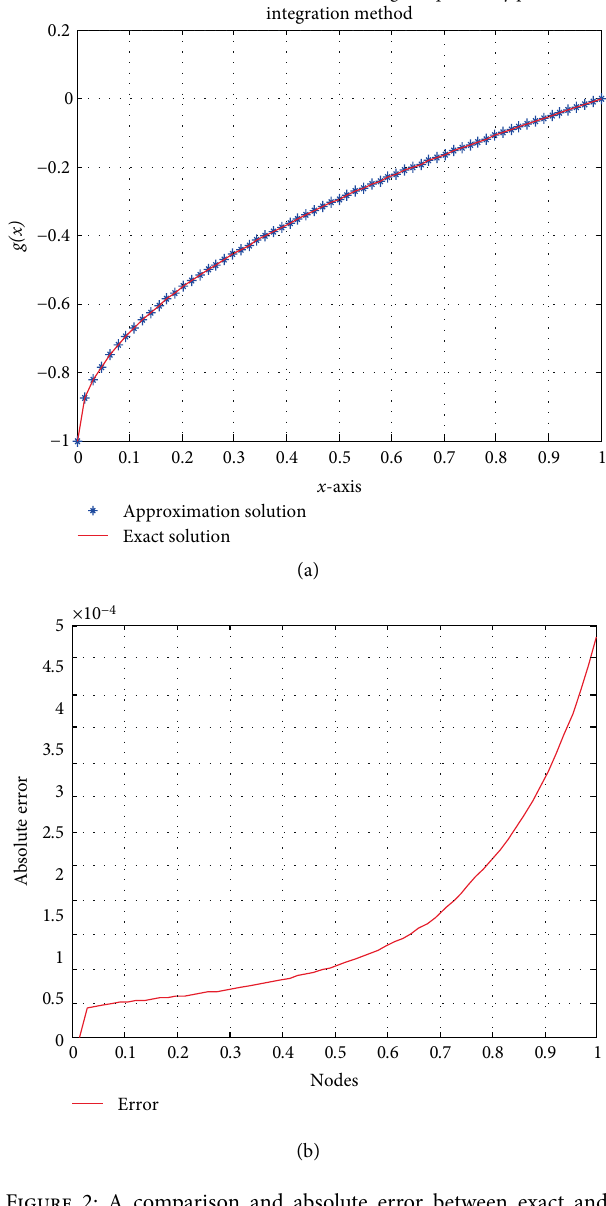
Figure 2: A comparison and absolute error between exact and numerical solutions in Example 1 with 𝑁 = 64 . (a) A comparison. (b)